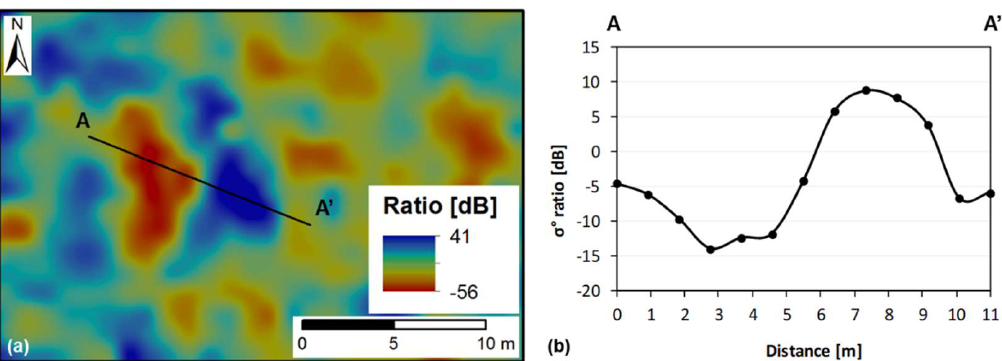
Figure 16. ( a ) Looting mark from the COSMO-SkyMed SAR amplitude change detection map in Figure 15d and ( b ) σ 0 ratio profile A-A’. COSMO-SkyMed ® Products © ASI—Italian Space Agency—2018–2019. All Rights Reserved.